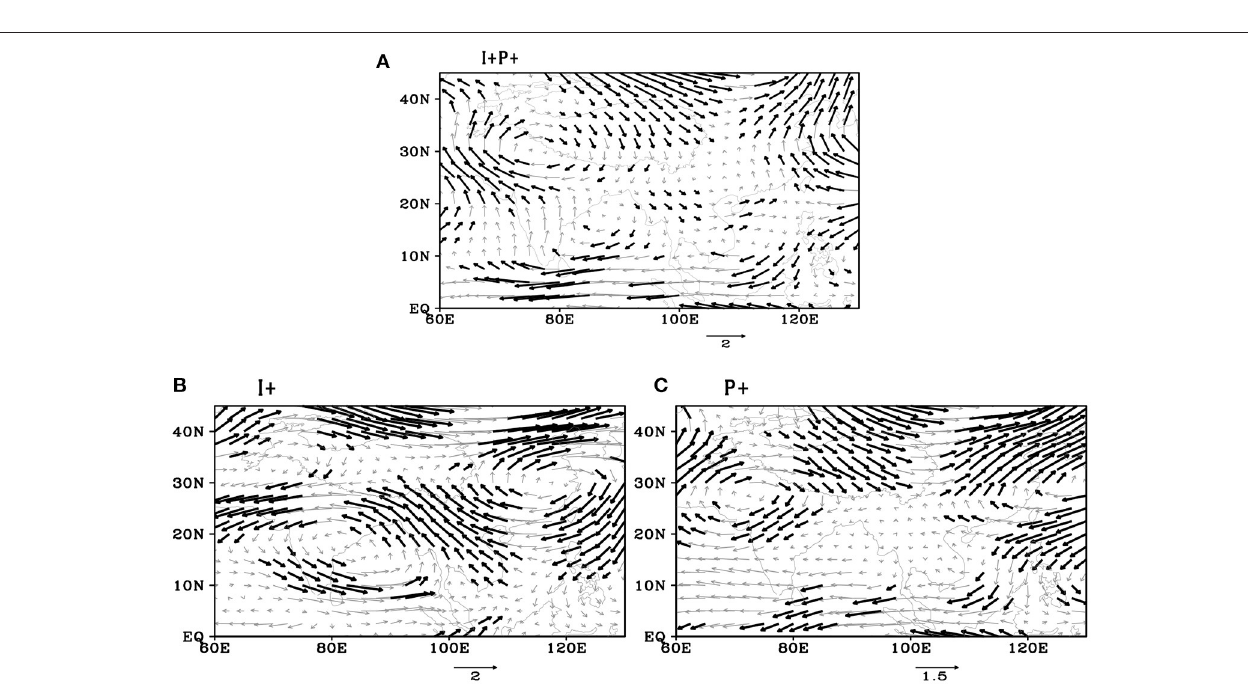
FIGURE 9 | As in Figure 8 , but for 500-hPa horizontal wind anomaly field (m s − 1 ). Bold vectors indicate that the values exceeding the 95% confidence level.